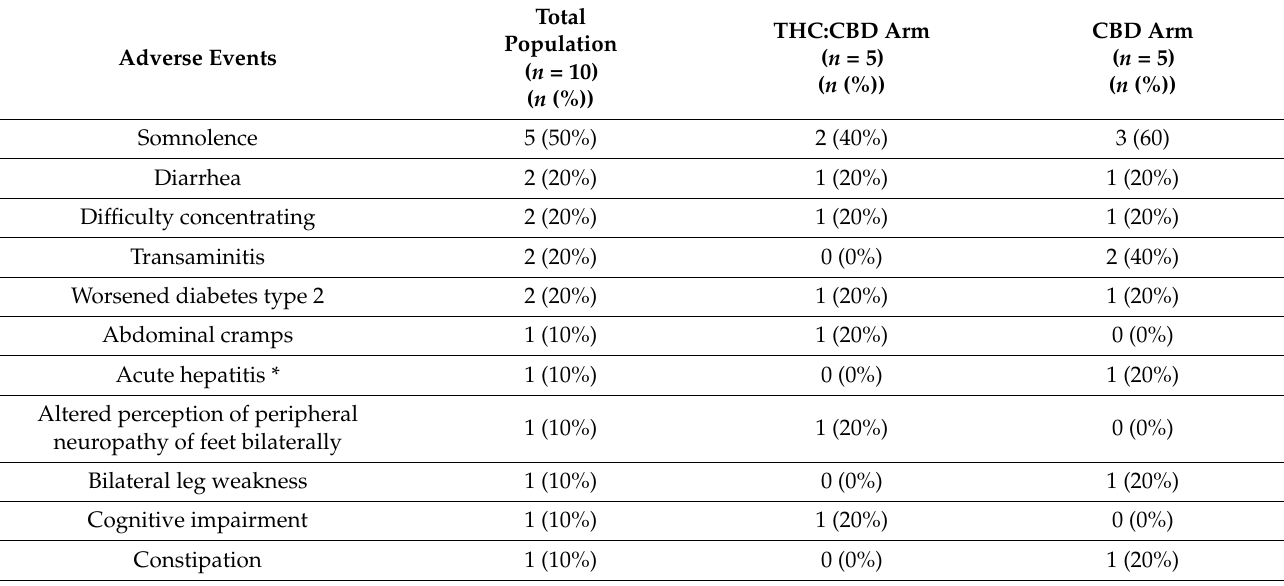
Table 3. List of adverse events (AEs) experienced by the participants during the study.